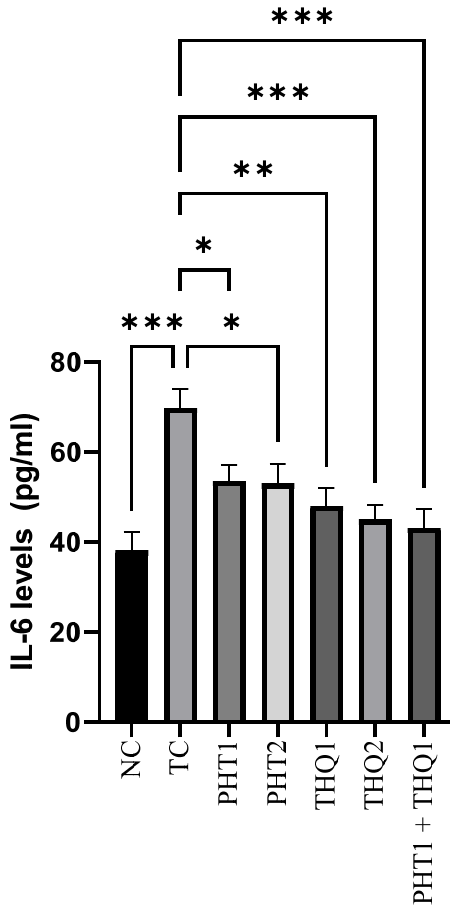
Figure 5. Effect of PHT (20 and 40 mg/kg), THQ (40 and 80 mg/kg) and PHT (20 mg/kg) + THQ (40 mg/kg) on hippocampal IL -6 levels following MES-induced convulsions in rats. One-way ANOVA followed by Dunnet’s test was used to compare quantitative variables from the toxic control vs. other groups. PHT, THQ, TC and MES indicate phenytoin, thymoquinone, toxic control and maximal electric shock, respectively. * p < 0.05, ** p < 0.01, *** p < 0.001